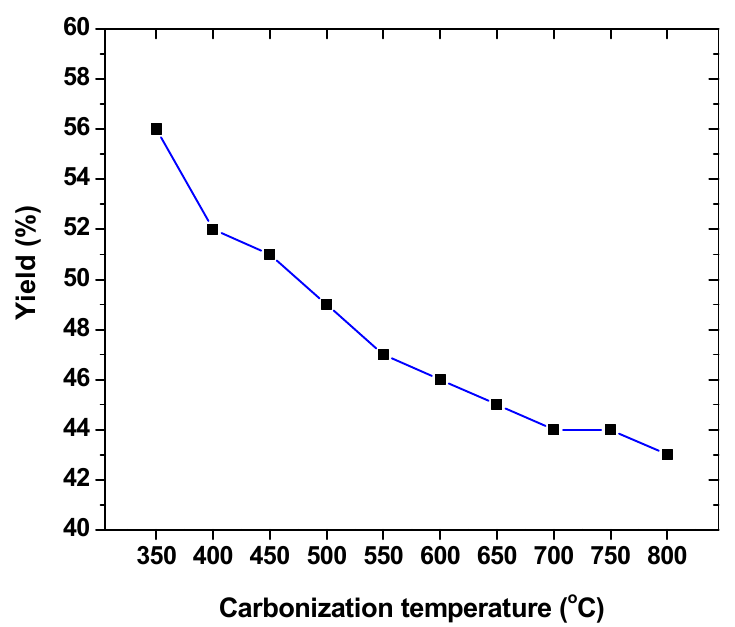
Figure 1. Effect of the carbonization temperature of the prepared samples on their yield.